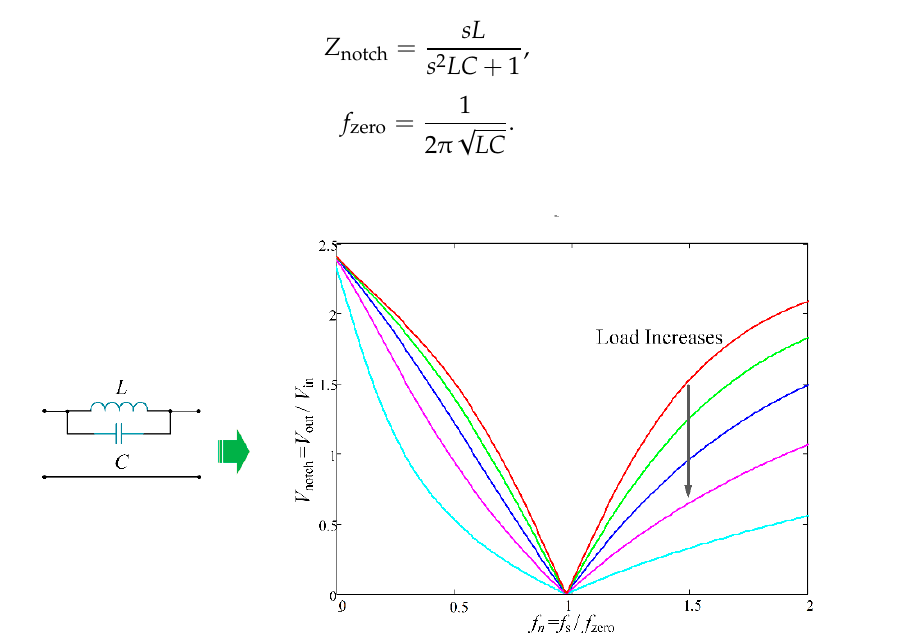
Figure 4. The topology and DC voltage gain curves of the notch filter.